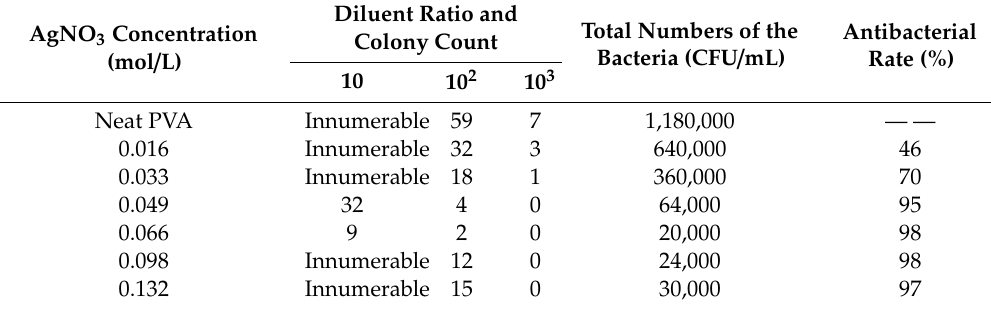
Table 1. Antibacterial test results by adsorption method for Ag / PVA CNFs prepared with di ff erent concentrations of AgNO 3 against E. coli .